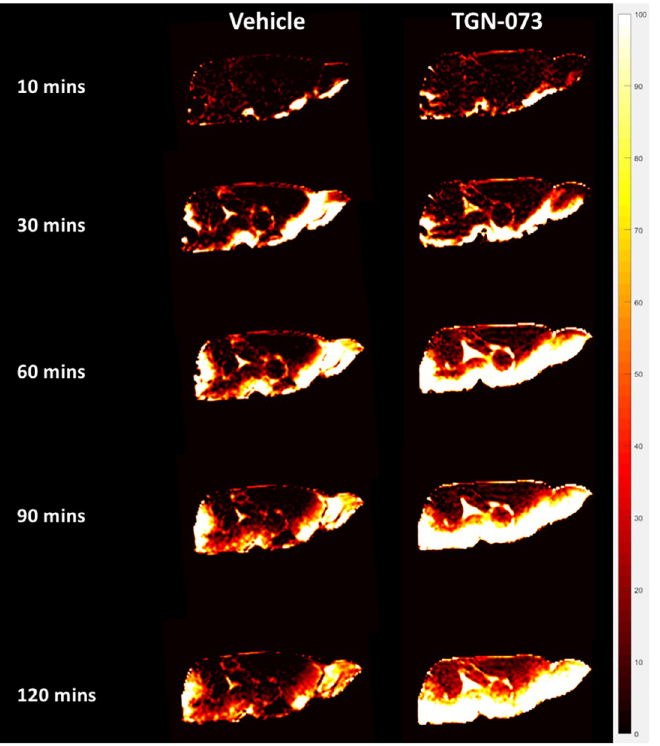
Fig 3. Serial MRI images in the sagittal plane of a rat’s brain. Using Gd-DTPA as the paramagnetic contrast agent reveals glymphatic transport with higher uptake and more parenchymal penetration over the whole brain over a period of two hours in the animals treated with the AQP4 facilitator (TGN-073) compared to vehicle-only treated rats. The time (in minutes) shows the change over time from starting the Gd-DTPA infusion.